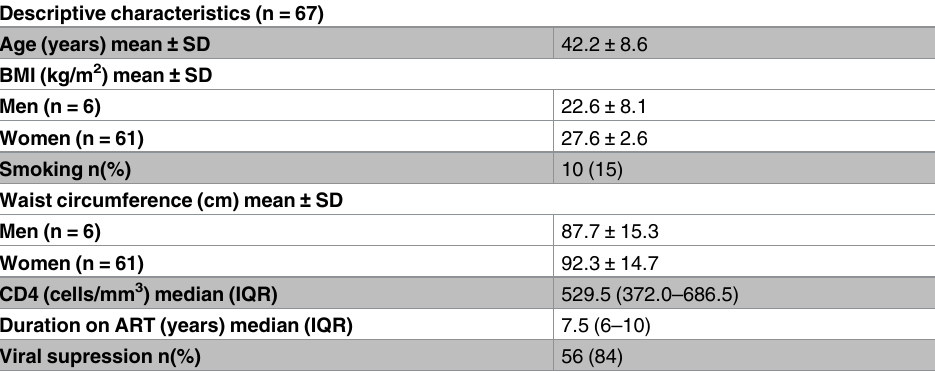
Table 1. Demographic, anthropometric and HIV-infection